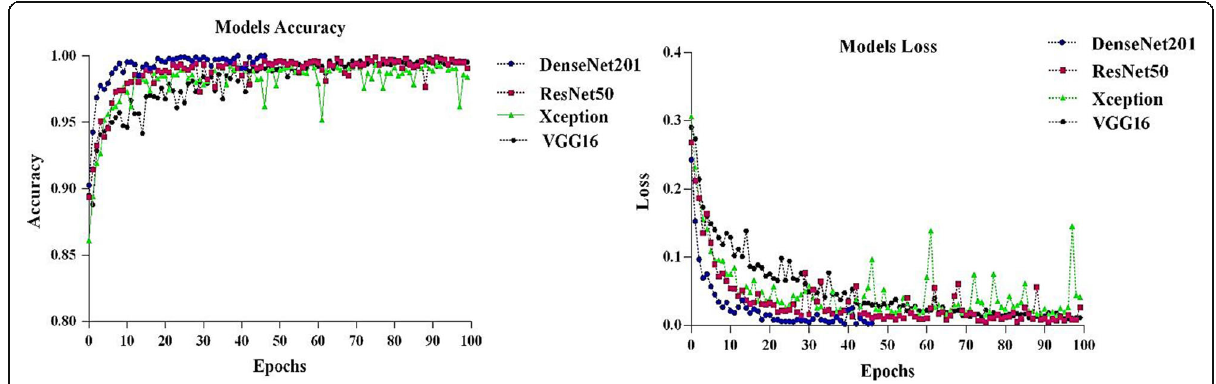
Fig. 3 The values of accuracy and loss for the pre-trained